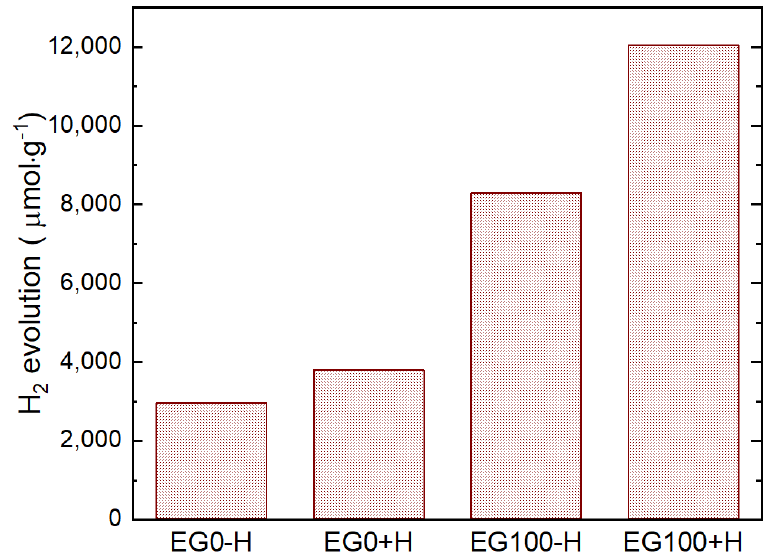
Figure 8. Comparison of the amounts of the evolved H 2 gas from various samples after 2 h of light irradiation.